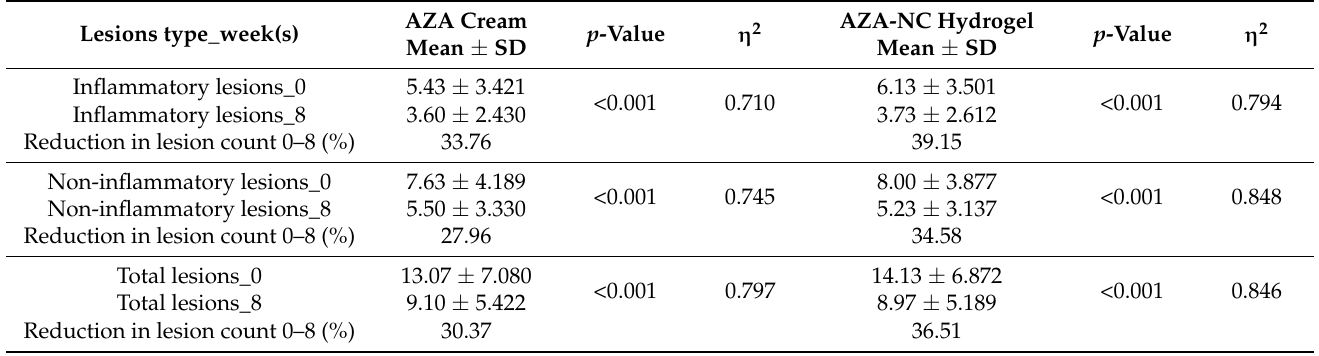
Table 5. Efficacy of treatment on reducing the number of inflammatory, non-inflammatory, and total lesions within a given group after eight